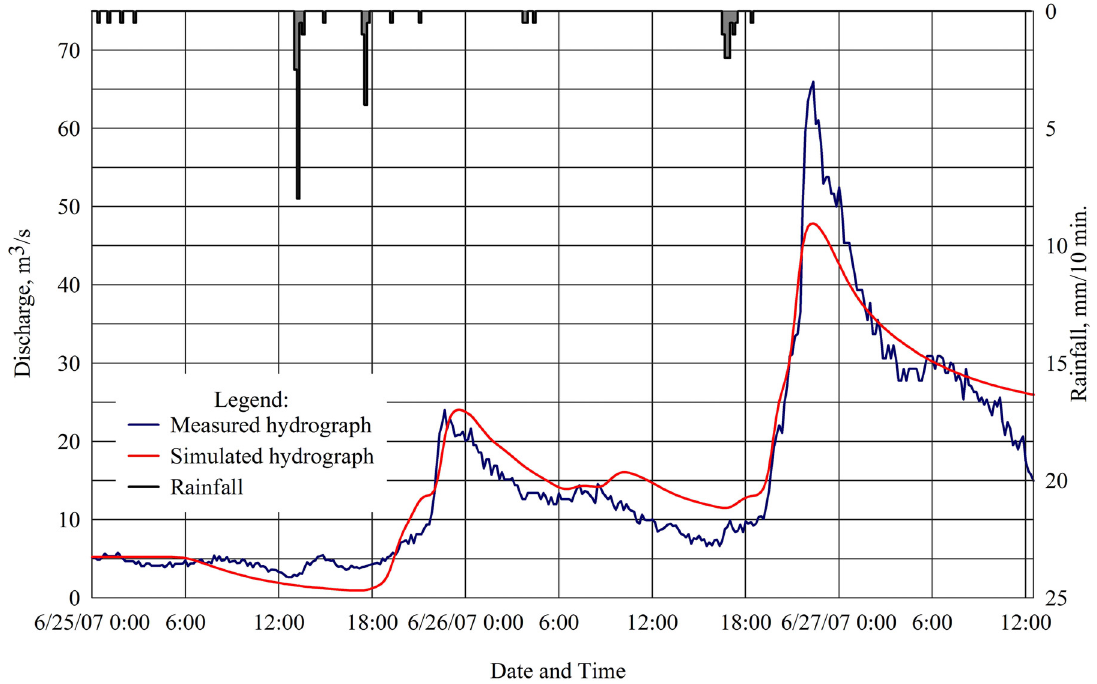
Figure 3. Results of hydrologic model calibration. The graph shows a comparison between the actual (measured) hydrograph simulated by the model and the measured hydrograph 25–27 June